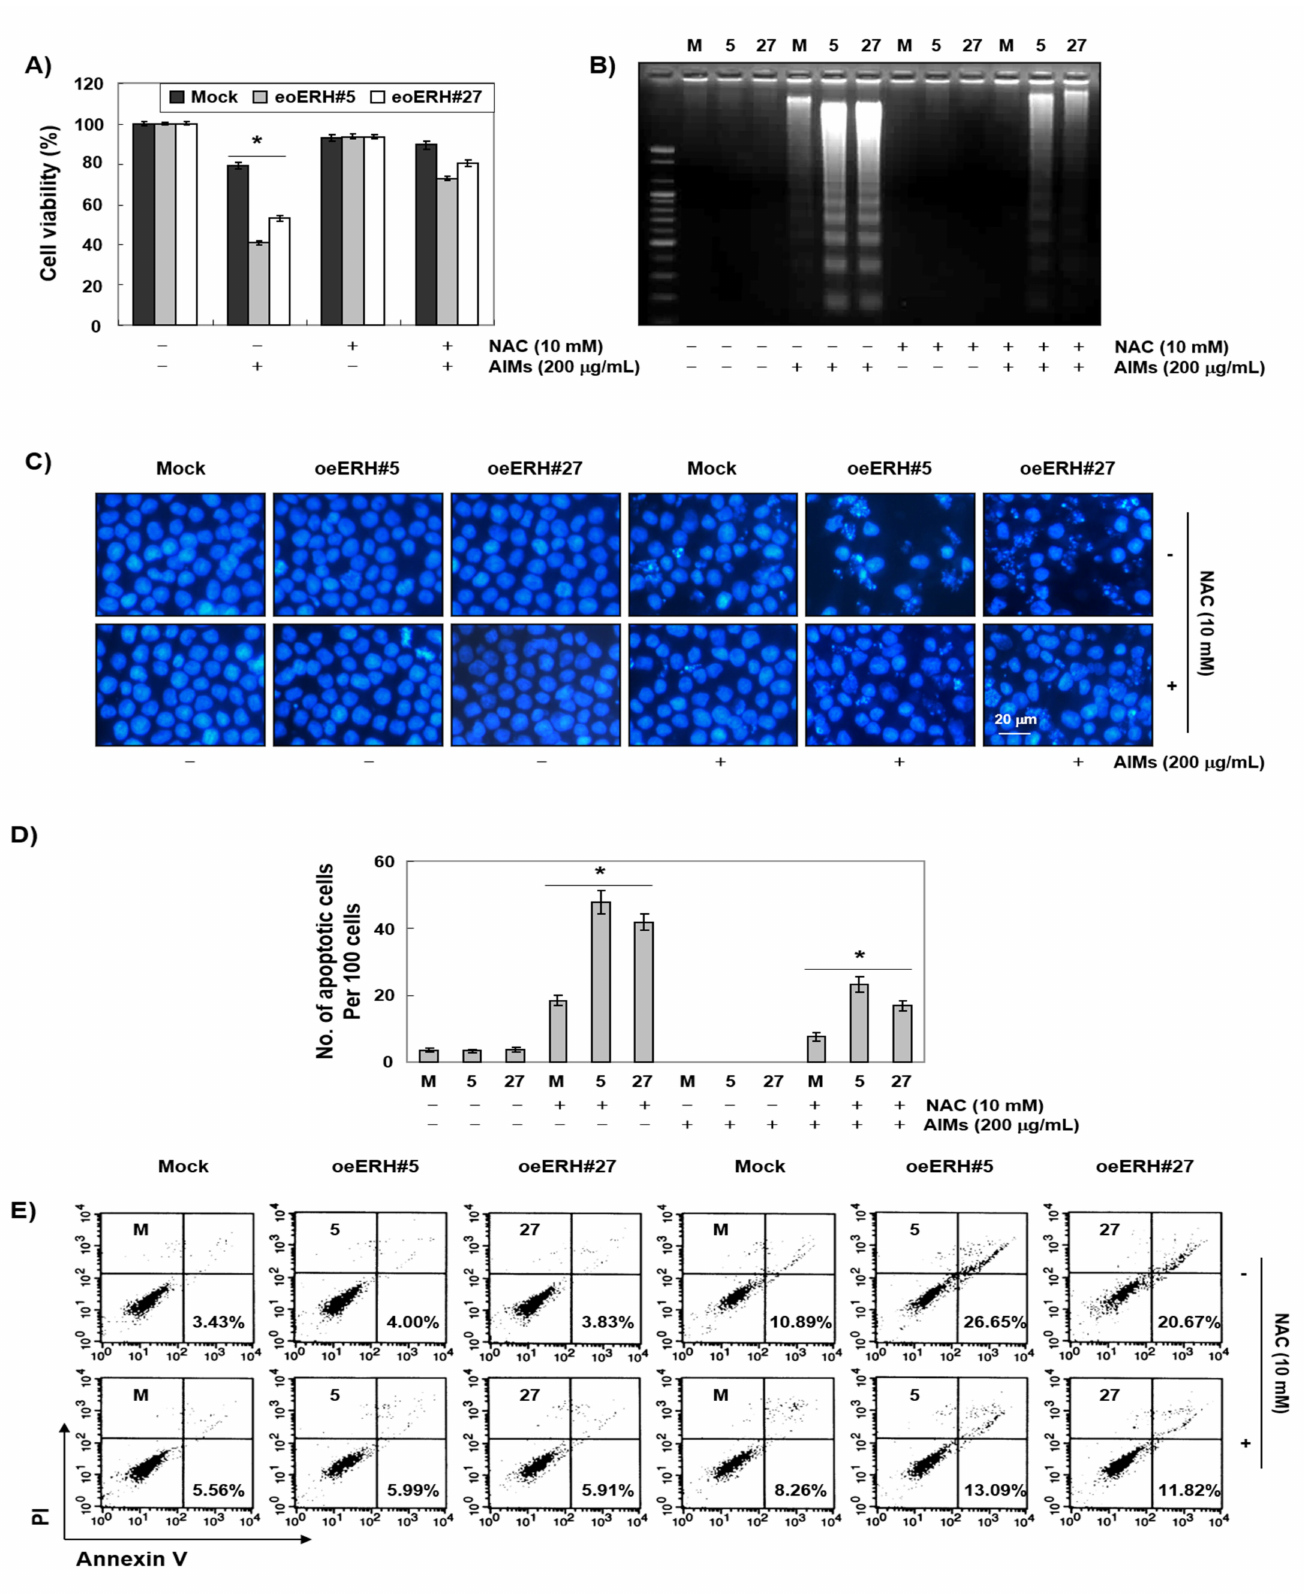
Figure 7. Another mechanism for ERH-augmented apoptotic effect on AIM-treated cells: excessive ROS generation triggered by AIMs. The cells were seeded at the density of 5 × 10 4 cells per mL. The two kinds of E-MKN28 cells (eoERH#5 and eoERH#27) and M-MKN28 cells were treated with AIMs at the concentrations of 200 µ g/mL for 48 h. With NAC